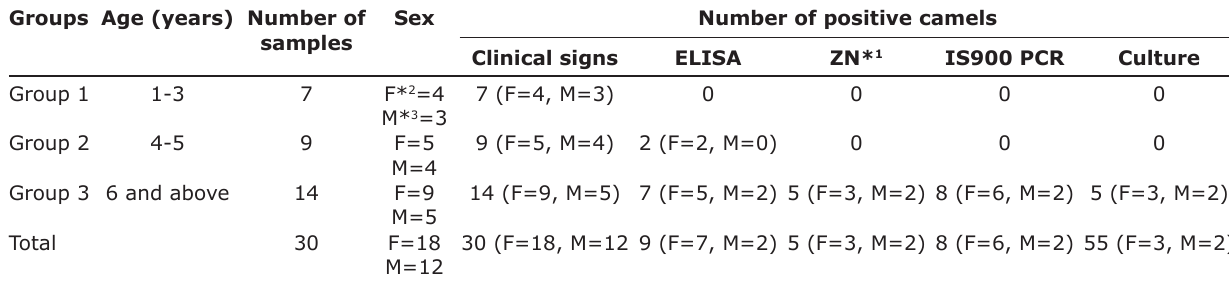
Table-1: Clinically positive camel (n=30) demographics and results. Groups Age (years) Number of